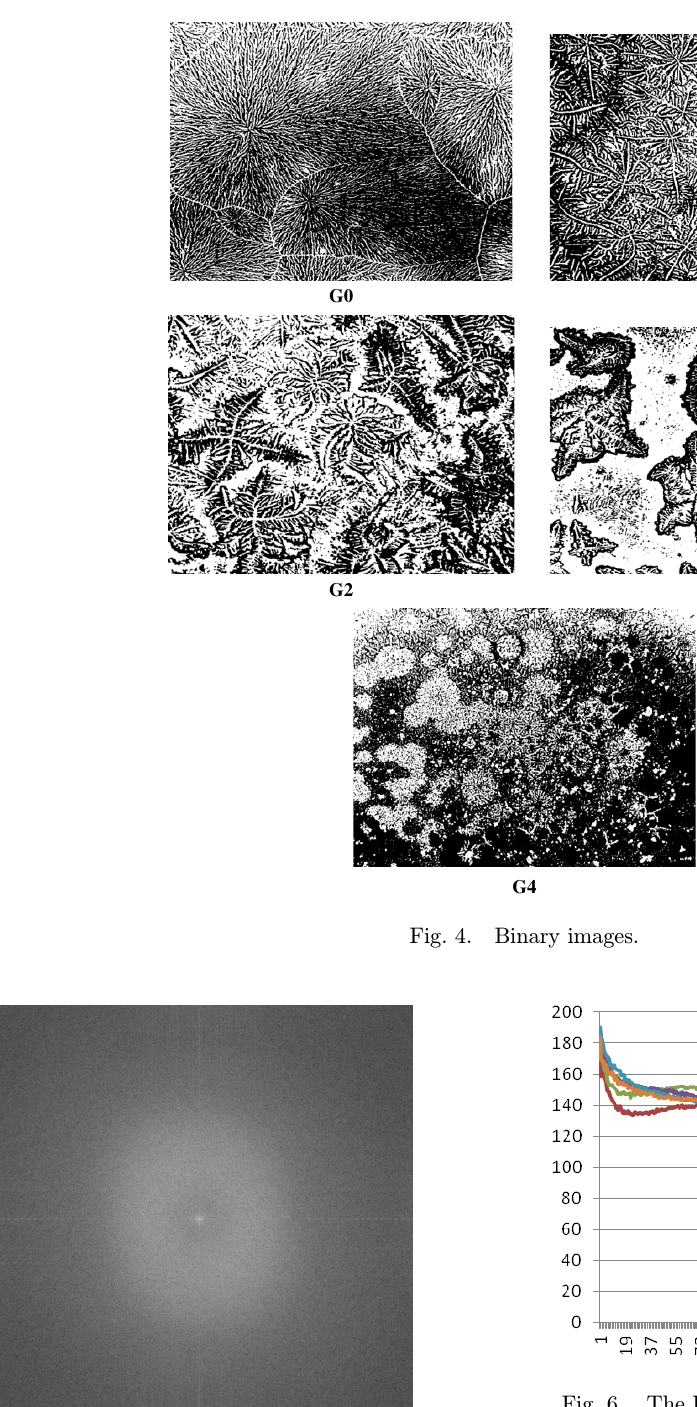
Fig. 6. The Radial plots of PS for ¯ve-grade scale images.